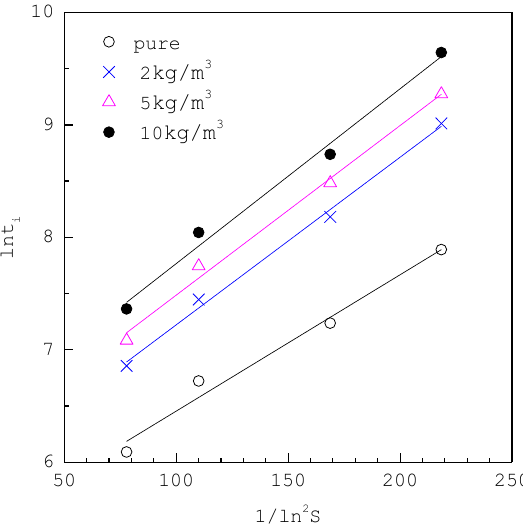
Figure 3. Plots of ln𝑡 𝑖 against ln 2 𝑆 𝑚 for various impurity concentrations, 𝐶 𝑖𝑚 , according to Equation (6) based on the induction time data without consideration of the lag time.